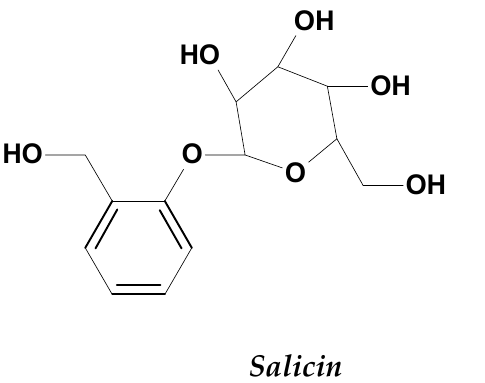
Figure 6. The structure of vernodalin.